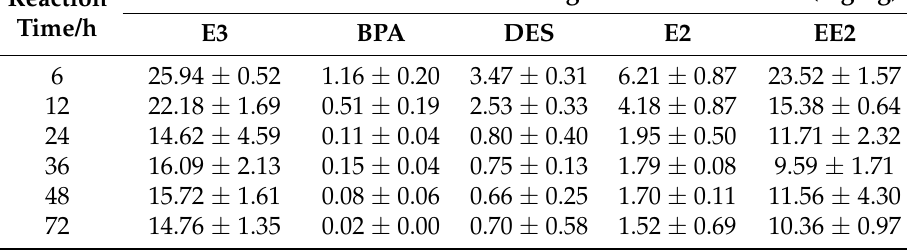
Table 6. Effect of reaction time on the residual concentrations of estrogens in cow manure. Note: Fe(II) to H 2 O 2 molar ratio = 0.10 M/M; H 2 O 2 dosage = 2.56 mmol/g; solid to water mass ratio = 2 g/mL; initial pH values = 3.0.